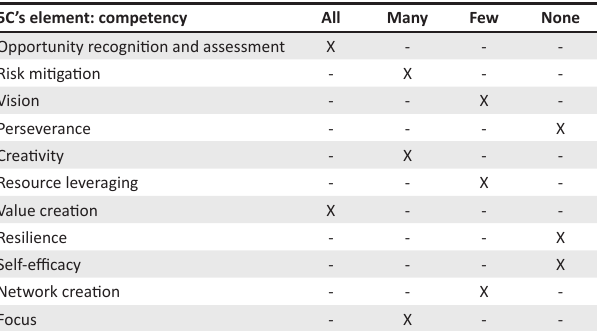
TABLE 5: Competencies taught in entrepreneurship modules at traditional South African universities. 5C’s element: competency